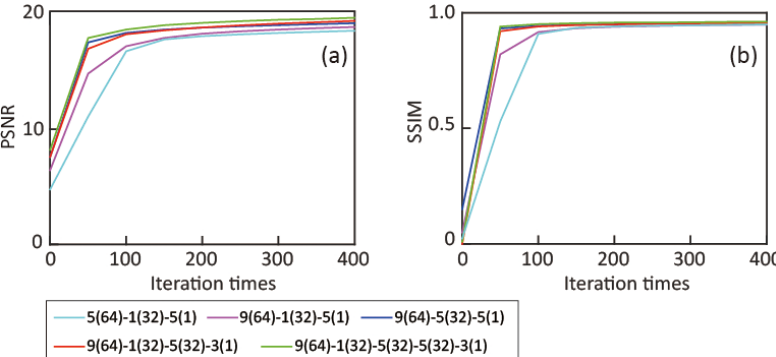
Figure A6. Model performance PSNR (a) and SSIM (b) calculated for the test dataset with varying SRCNN filter depths and filter sizes. Numbers are as follows: 5-1-5 in 5(64)-1(32)-5(1) represents the filter size in layers 1, 2 and 3, respectively, and (64)-(32)-(1) represents the number of output images of layers 1, 2 and 3.